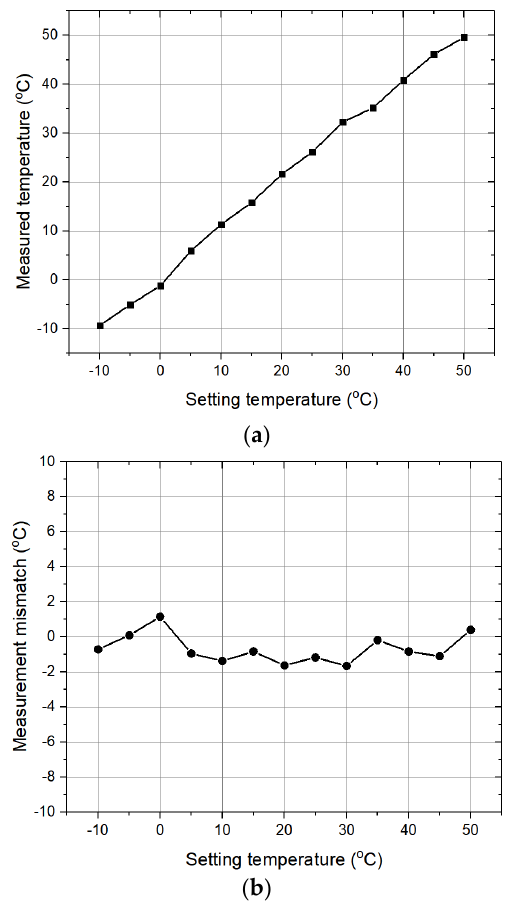
Figure 8. Temperature measured by the system for different setting temperatures. ( a ) Measured temperatures; ( b ) Temperature measurement